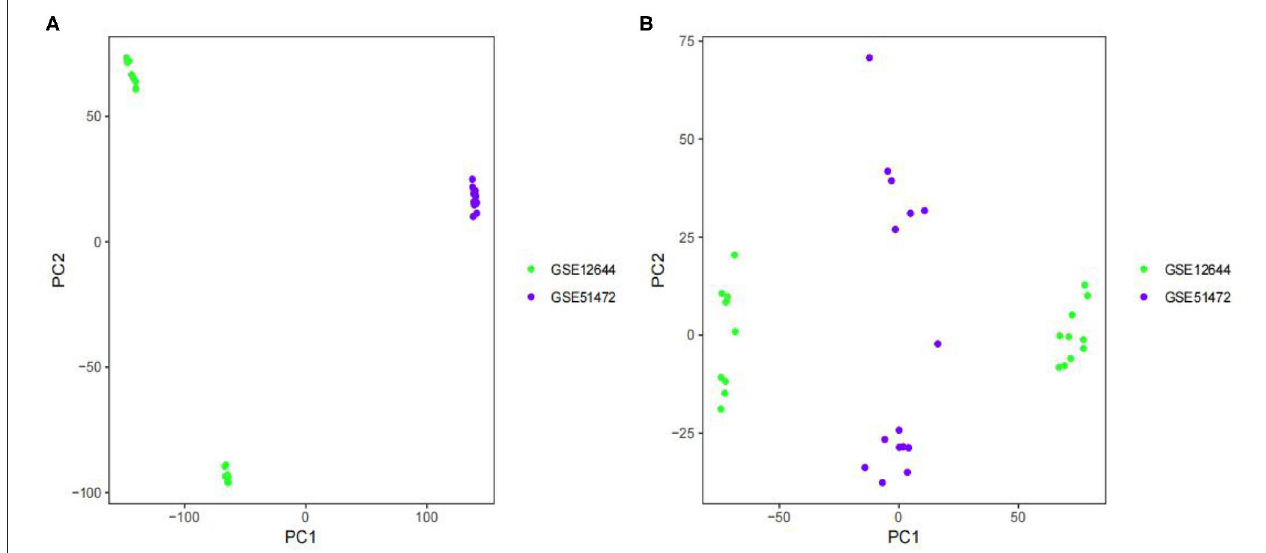
FIGURE 1 | Principal component analysis (PCA) analysis of gene expression datasets. The scatter plots’ points depict samples based on the top two principal components (PC1 and PC2) of gene expression profiles without and with batch effect removal. (A) PCA cluster plot of GSE12644 and GSE51472 before sample correction and remove batch effect. (B) PCA cluster plot of GSE12644 and GSE51472 after sample correction and remove batch effect. The colors denote samples from two distinct datasets, respectively. Each dot represents a sample; green represents a sample from GSE12644; purple represents a sample from